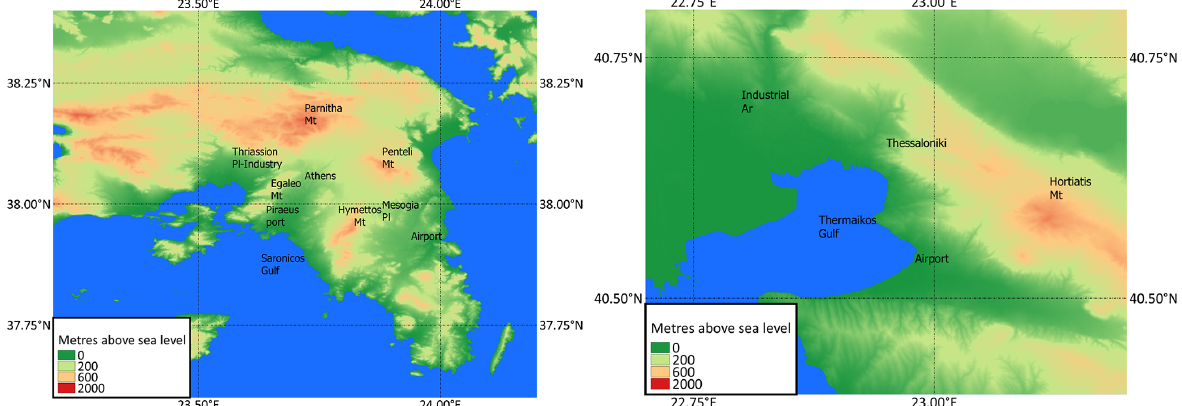
Figure 1. The topographic features that affect air pollution as well as the areas of known NO x sources in Athens (left) and Thessaloniki (right); Mt refers to mountain, Pl to plain and Ar to area (created using https://land.copernicus.eu/imagery-in-situ/eu-dem/eu-dem-v1.1 (last access: 24 March 2021) and QGIS